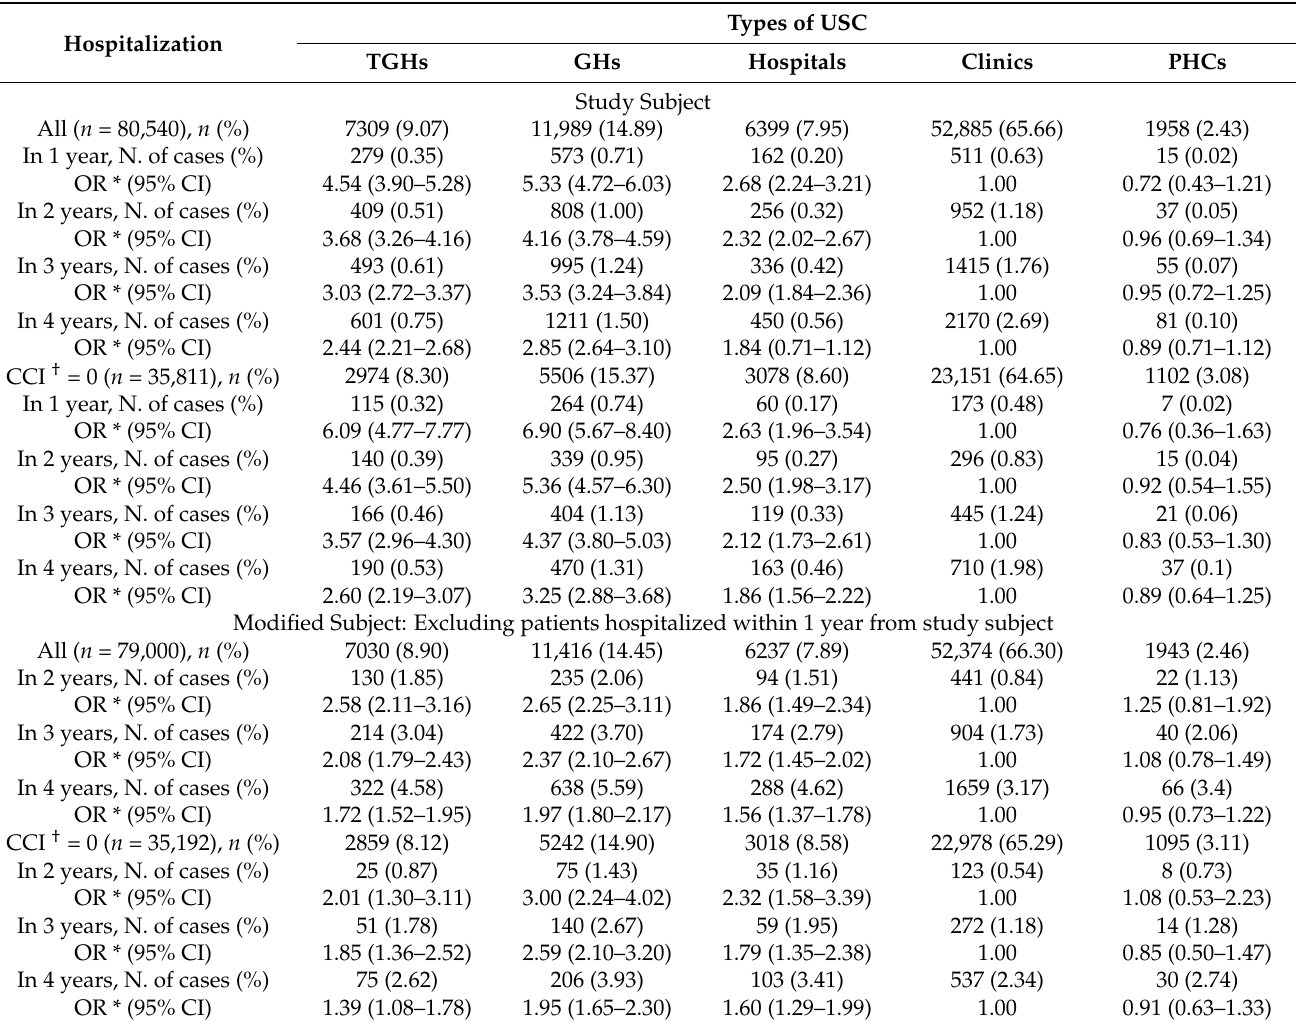
Table 2. Diabetes-related Hospitalization by USC